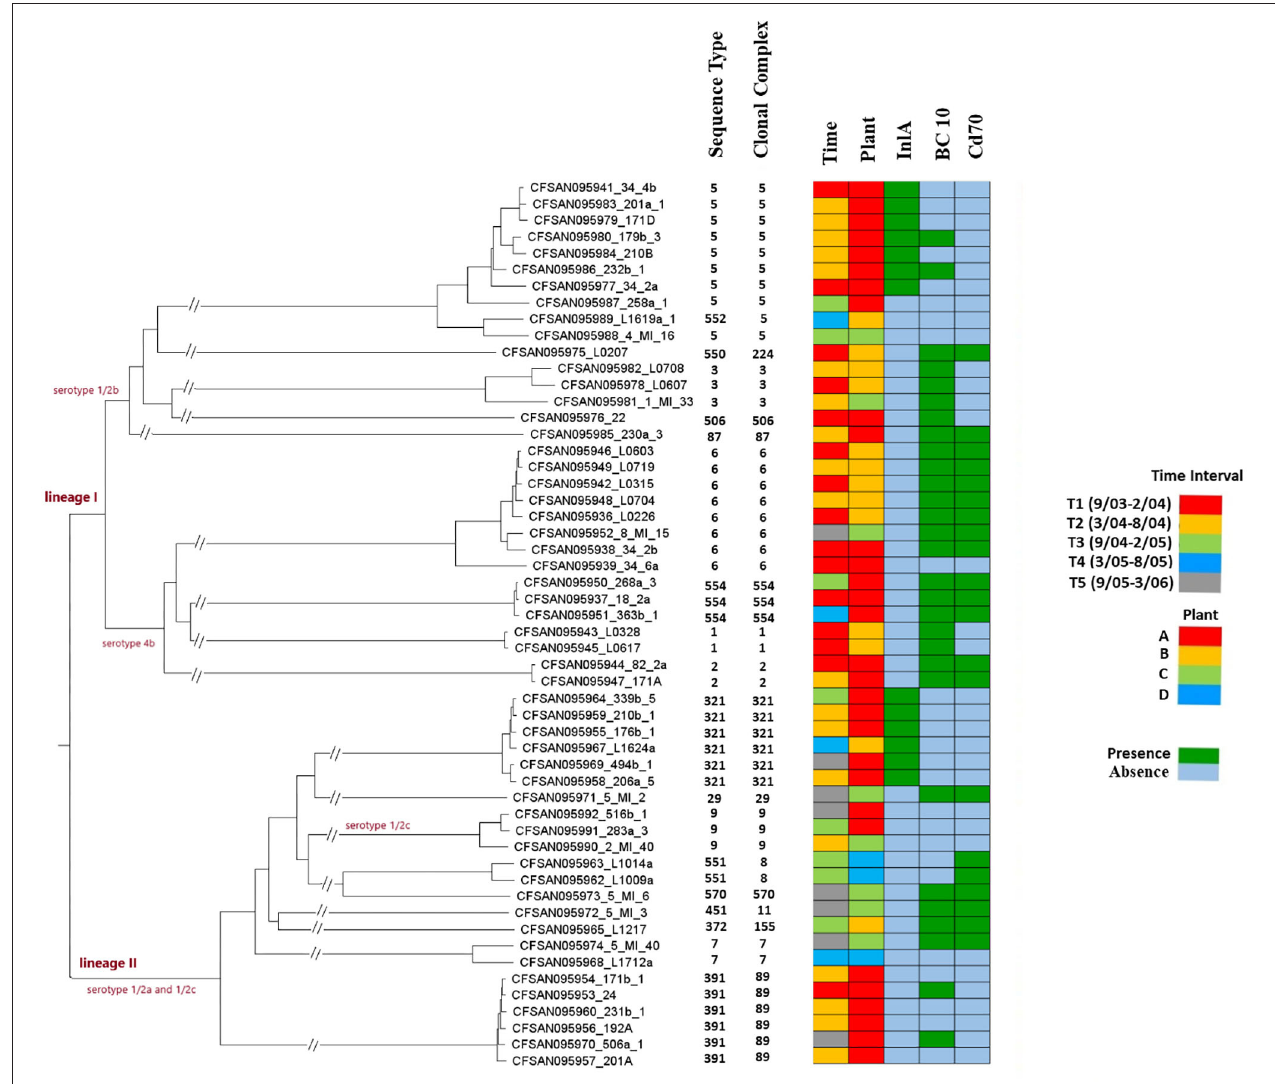
FIGURE 2 | Whole genome MLST-based phylogenetic tree of the 54 L. monocytogenes strains from Plants A-D. Sequence type (ST) and clonal complex (CC) designations are based on the seven-locus MLST scheme. Plant of origin and time period during which the strain was isolated are indicated as shown in the insets. InlA PMSC indicates presence or absence of premature stop codons (PMSCs) in InlA , as shown in the inset. BC10 and CD70 indicate presence or absence of resistance to benzalkonium chloride (BC) and cadmium (CD), respectively, as shown in the inset and resistance was tested as described in Materials and Methods. Two parallel diagonal lines on a branch indicates a break in order to fit greater phylogenetic distances on a single